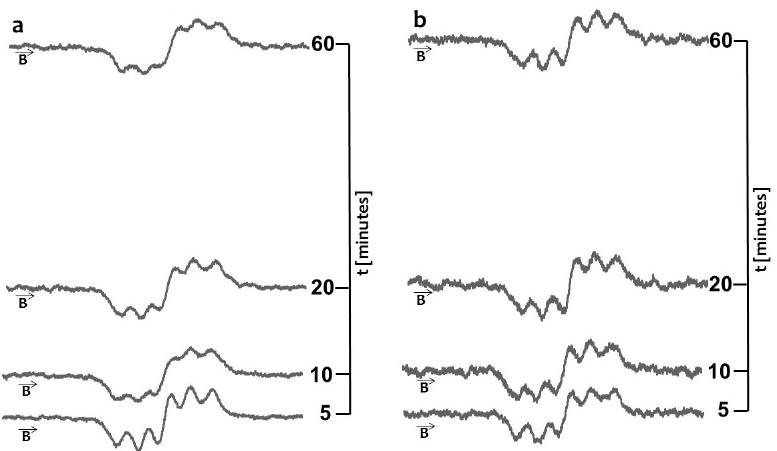
Figure 5. EPR spectra of DPPH interacting with ( a ) propolis drops and ( b ) propolis spray UV-irradiated for 5 min, 10 min, 20 min, 60 min. B —magnetic induction. Time of UV-irradiation was 30 min.